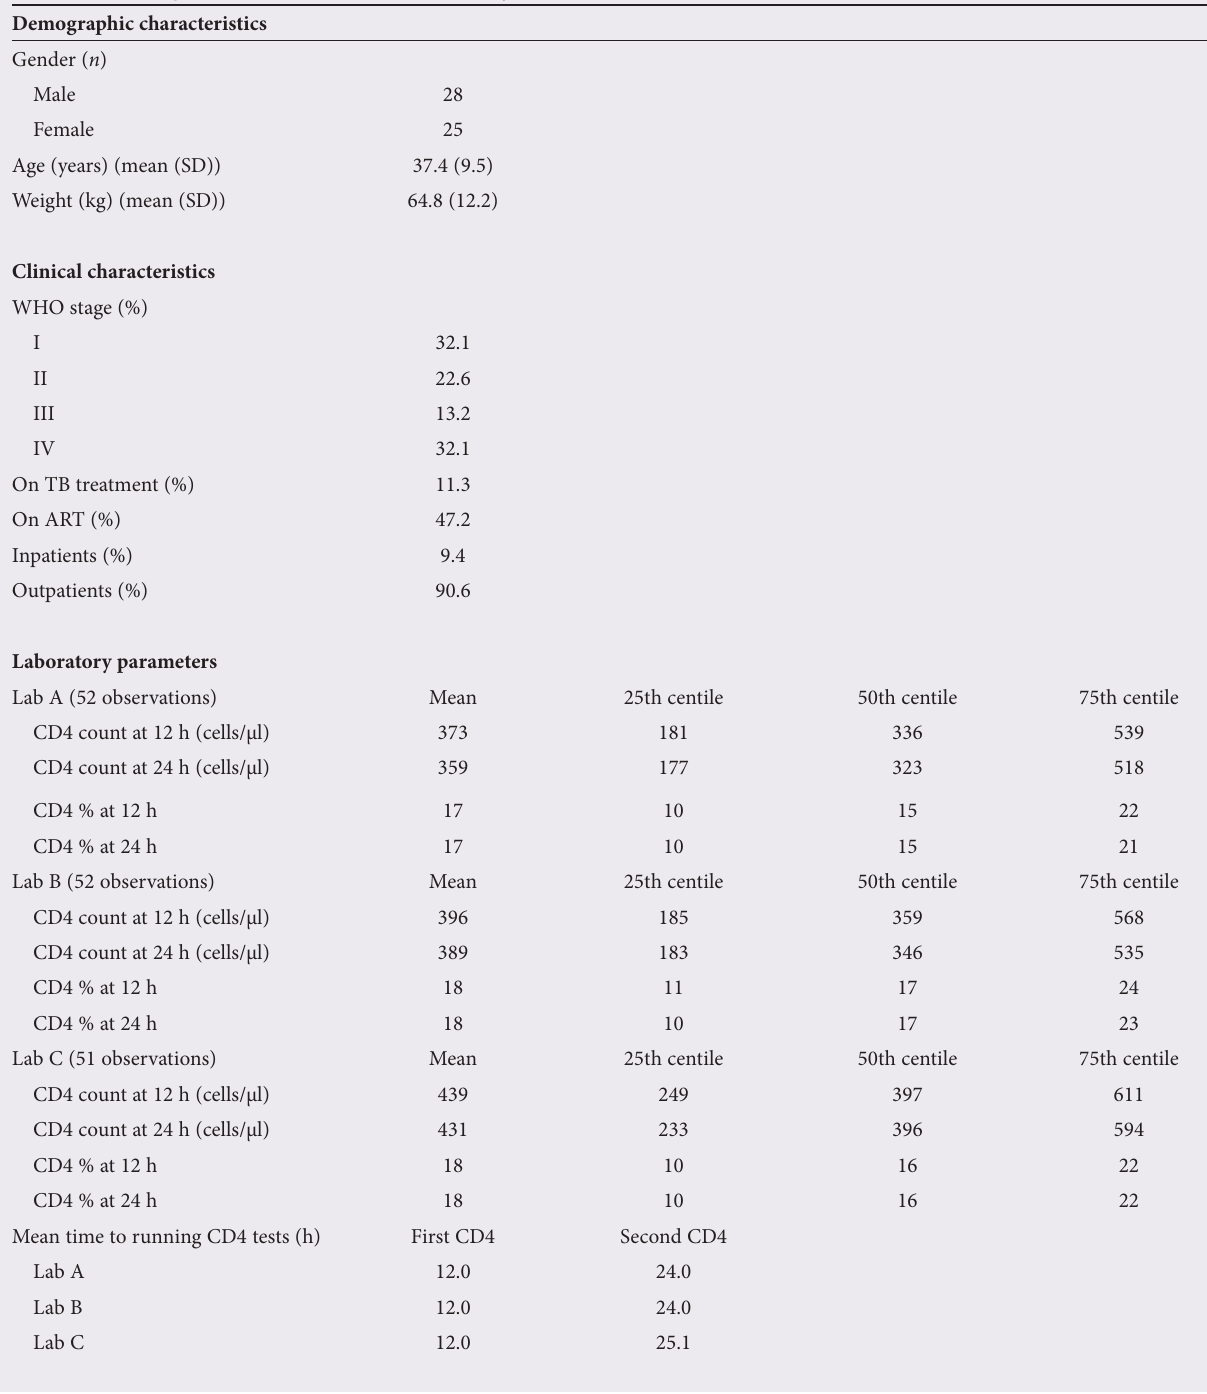
Table 1. Demographic, clinical and laboratory data of participants Demographic